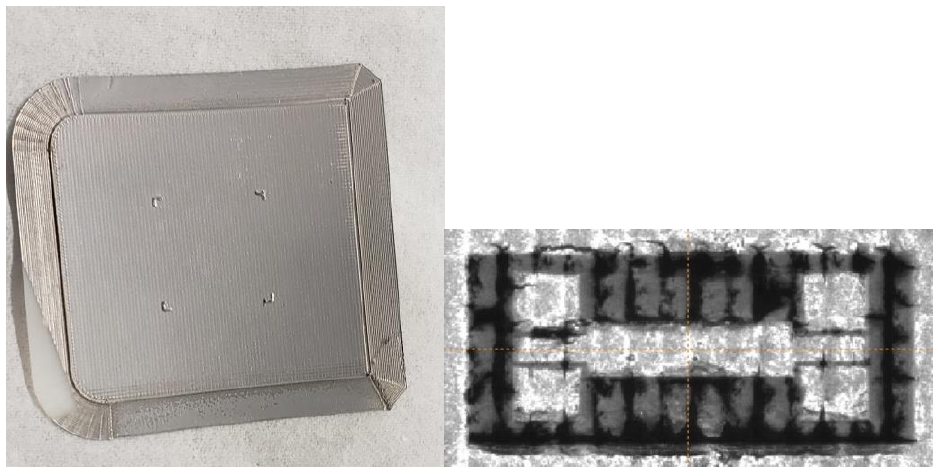
Figure 1. Left: HPS-FG77 air-brushed on AM ABS. Right: CPW transmission lines produced by laser trimming the air-brushed HPS-FG77 on ABS material. Appl. Sci. 2020 , 10 , x FOR PEER REVIEW 87 of 94